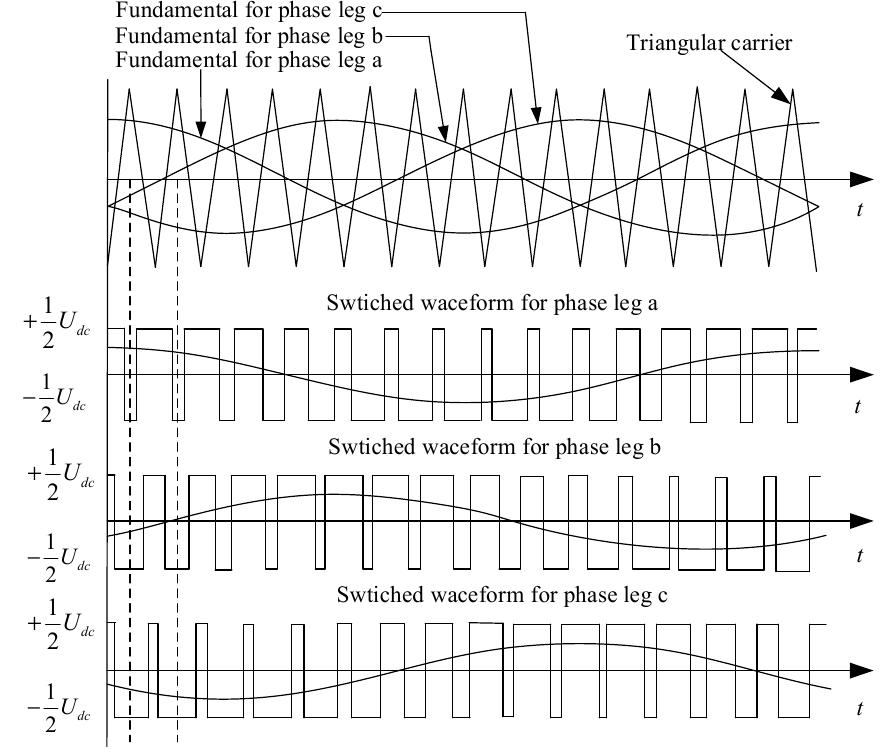
Figure 3. Typical working principle of SPWM in the three-phase PMSM drive system.